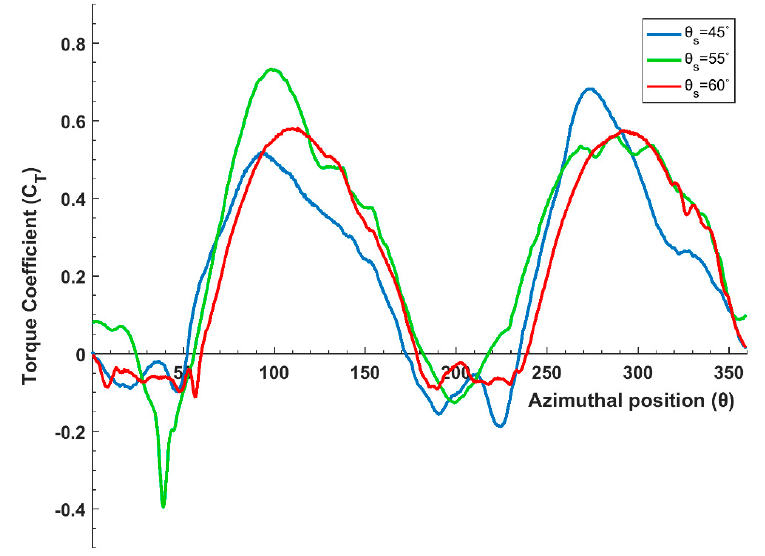
Figure 6. Instantaneous torque coefficient for three Savonius configurations at a tip speed ratio (TSR) of 0.6.